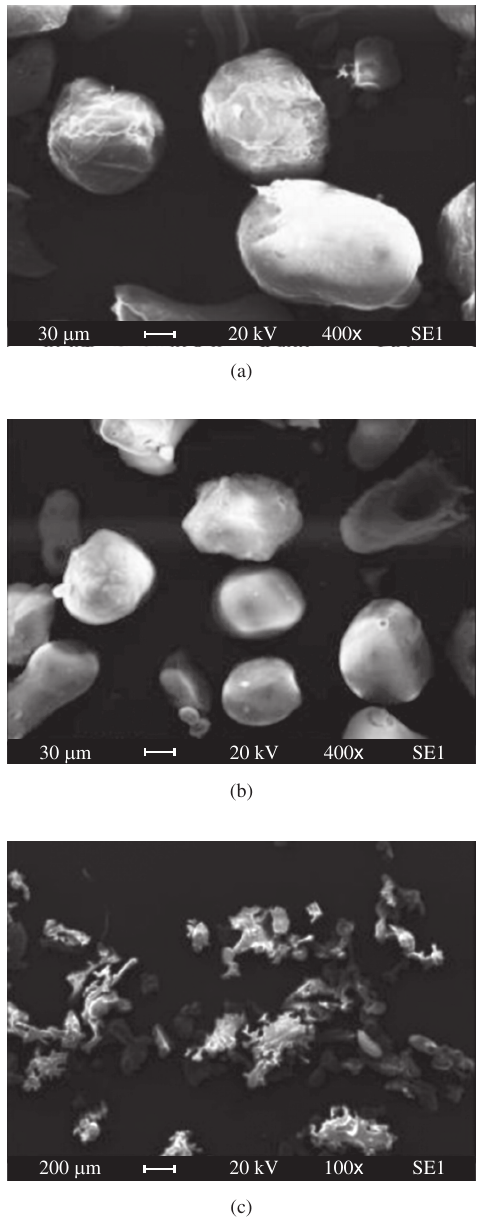
Figure 7. a) Scanning electron micrograph of chitosan microspheres, modified with epychlorohydrin; b) Scanning electron micrograph of chitosan micro- spheres, modified with glutaraldehyde; and c) Scanning electron micrograph of chitosan microspheres, modified with acetic anhydride.